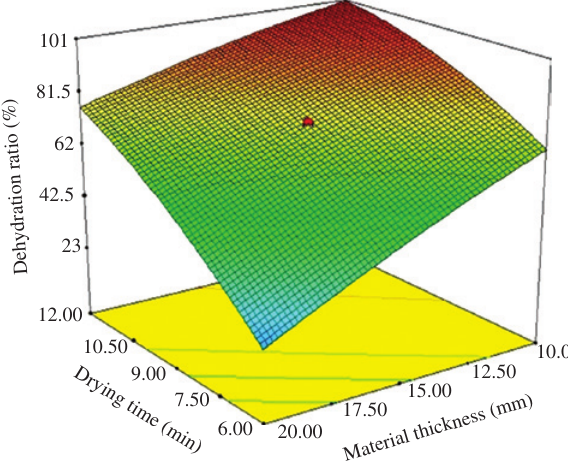
Figure 3: Interactive effect of material thickness and drying time on dehydration ratio.